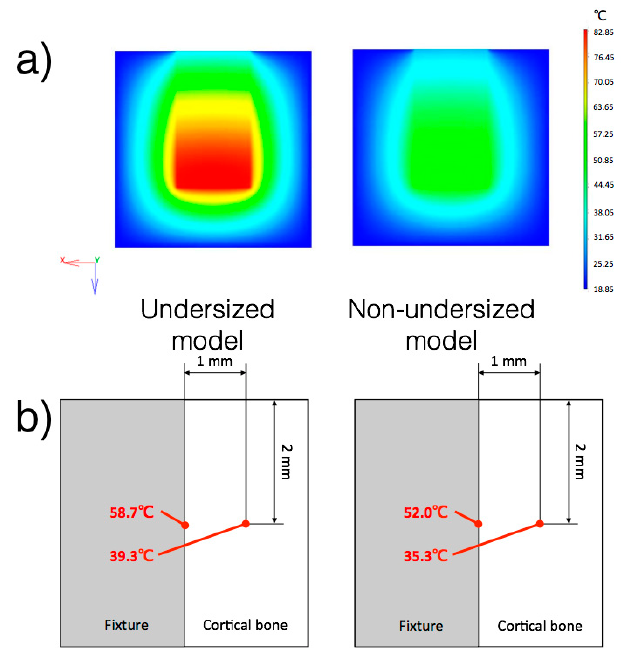
Figure 5. ( a ) The temperature distribution calculated on the Finite Element Model (FEM). The undersized drilling model and non-undersized model are displayed on the left and on the right, respectively. The temperature is displayed in °C. Note how the heat is poorly distributed around the implant surface. This means that the overheating risk is limited to the bone in the proximity to the implant. ( b ) Calculation of the bone temperature at the implant interface according to the FEM. This value was calculated by entering the value recorded with the thermocouple in the experimental part.